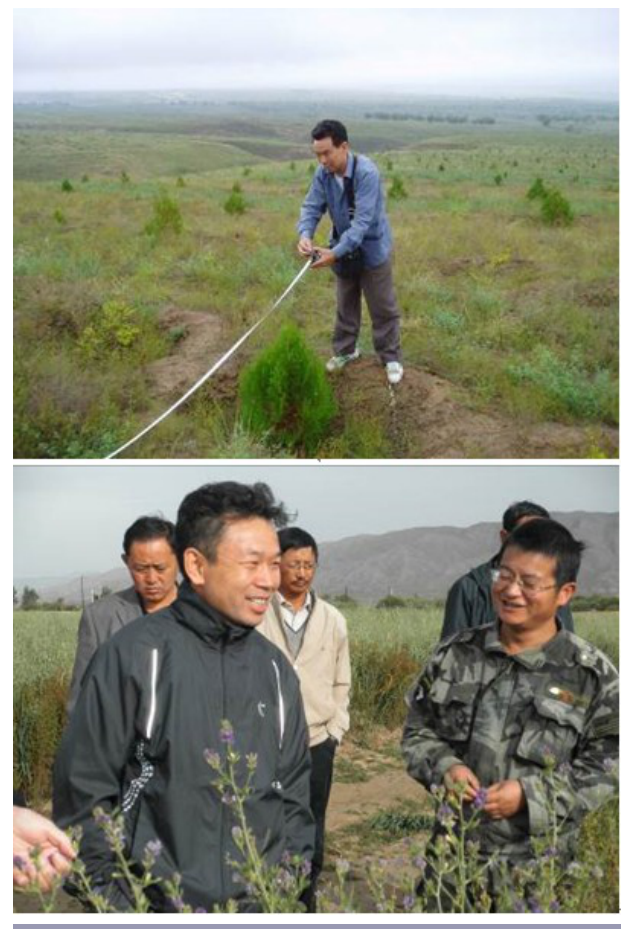
Fig. 1 . Shixiong Cao works both as an engineer who monitors the results of ecological restoration (Top) and as a social scholar who visits and teaches farmers in his spare time